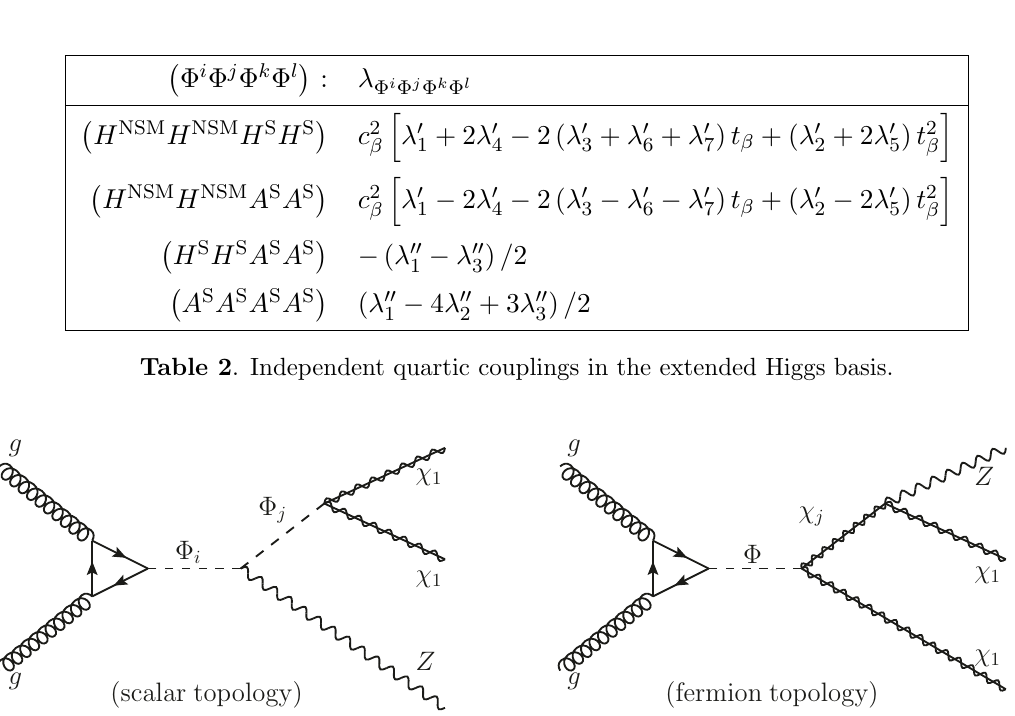
Figure 6 . Illustration of resonant decay channels yielding mono- Z signals at the LHC. For the left diagram, (cid:8) i = H and (cid:8) j = a , or (cid:8) i = A and (cid:8) j = h . Decays of the type A suppressed by alignment, see the discussion in section 2.3. This topology is henceforth referred to as the scalar topology . For the right diagram, (cid:8) = H or (cid:8) = A , and we refer to this topology as the fermion topology